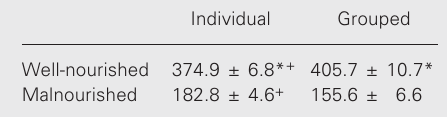
Table 1. Body weight of rats at the age of 70 days when behavioral tests were carried out. Individual